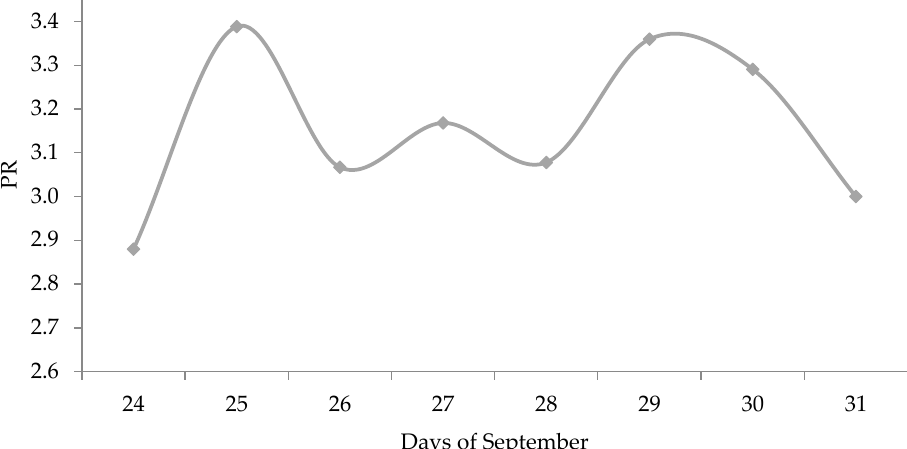
Figure 10. Measured performance ratio for the solar MSF system between 21 and 31 September. The Specific Energy Consumption (SEC)